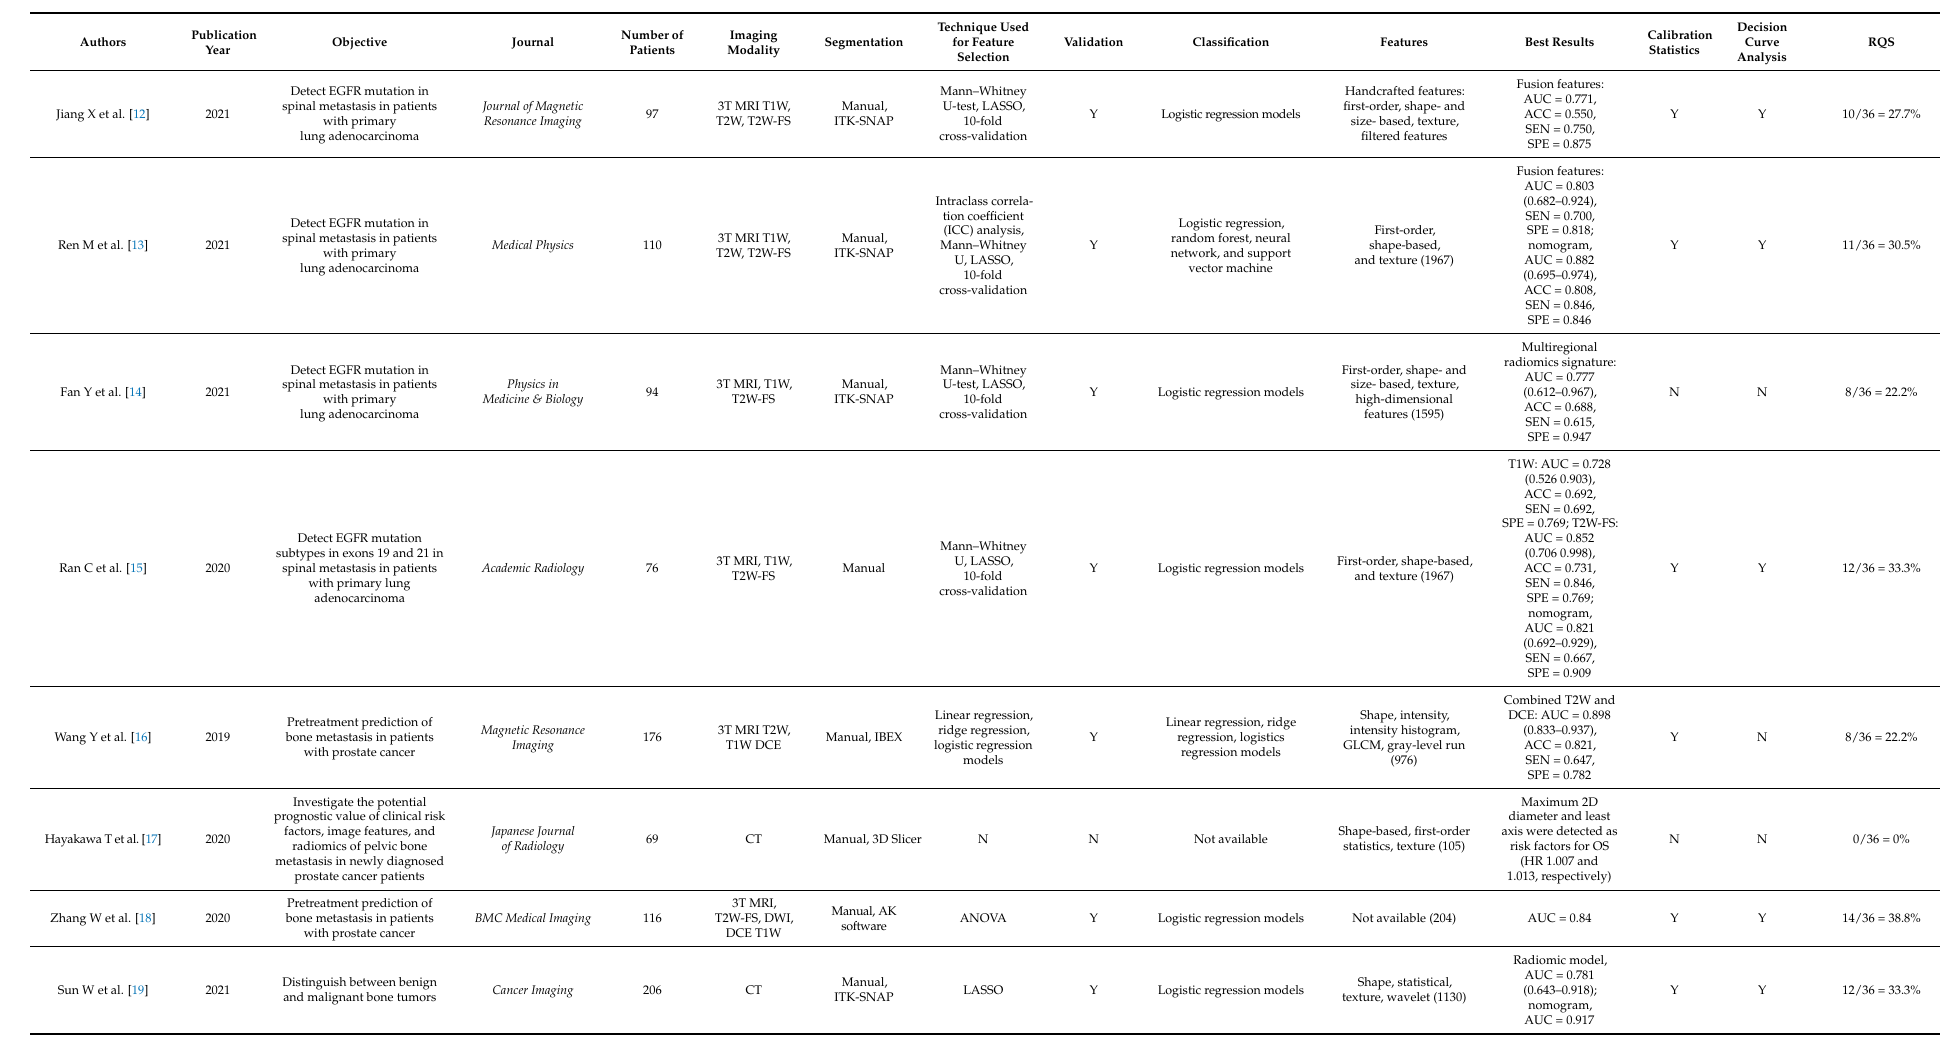
Table 1. Characteristics of the selected radiomics